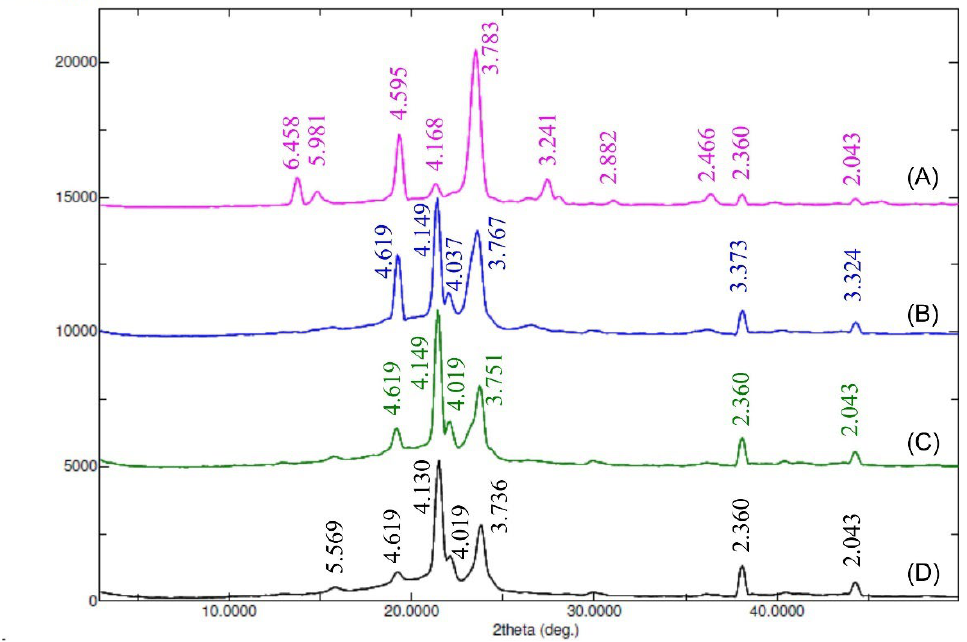
Figure 5. XRD diffractograms (peaks with d-values) of Myrj S100 ( A ), Myrj S100- b -PCL 44 ( B ), Myrj S100- b -PCL 88 ( C ), and Myrj S100- b -PCL 131 ( D ).